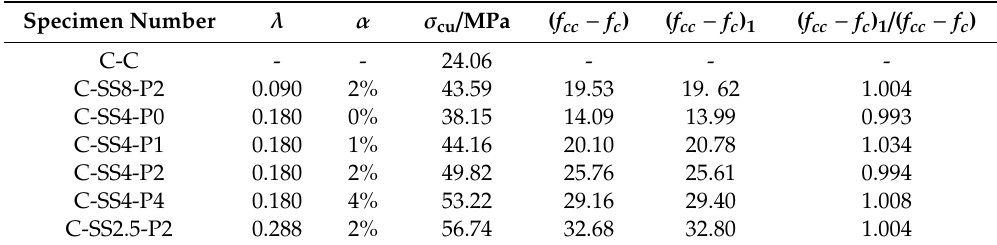
Table 5. Contribution of SMA wire compressive